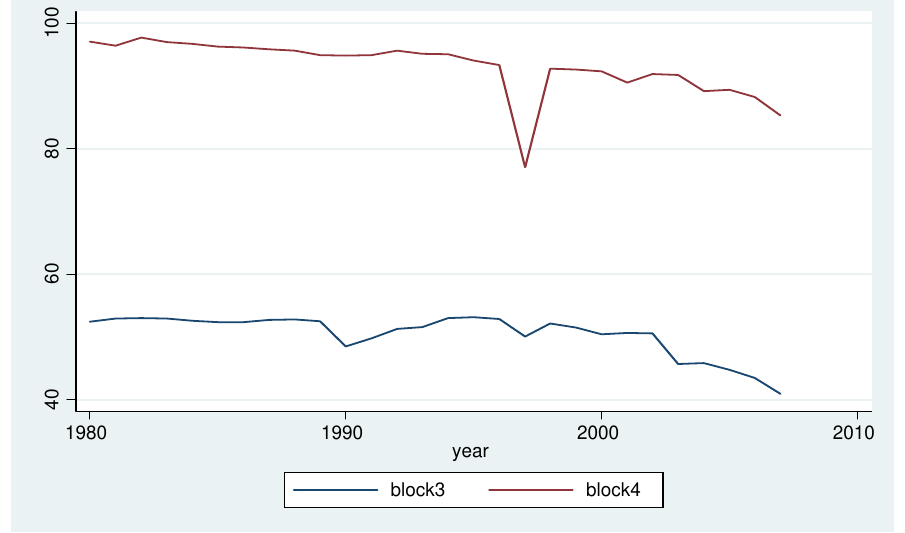
Fig. 2A. Upper consumption block (block 3 and 4), yearly average